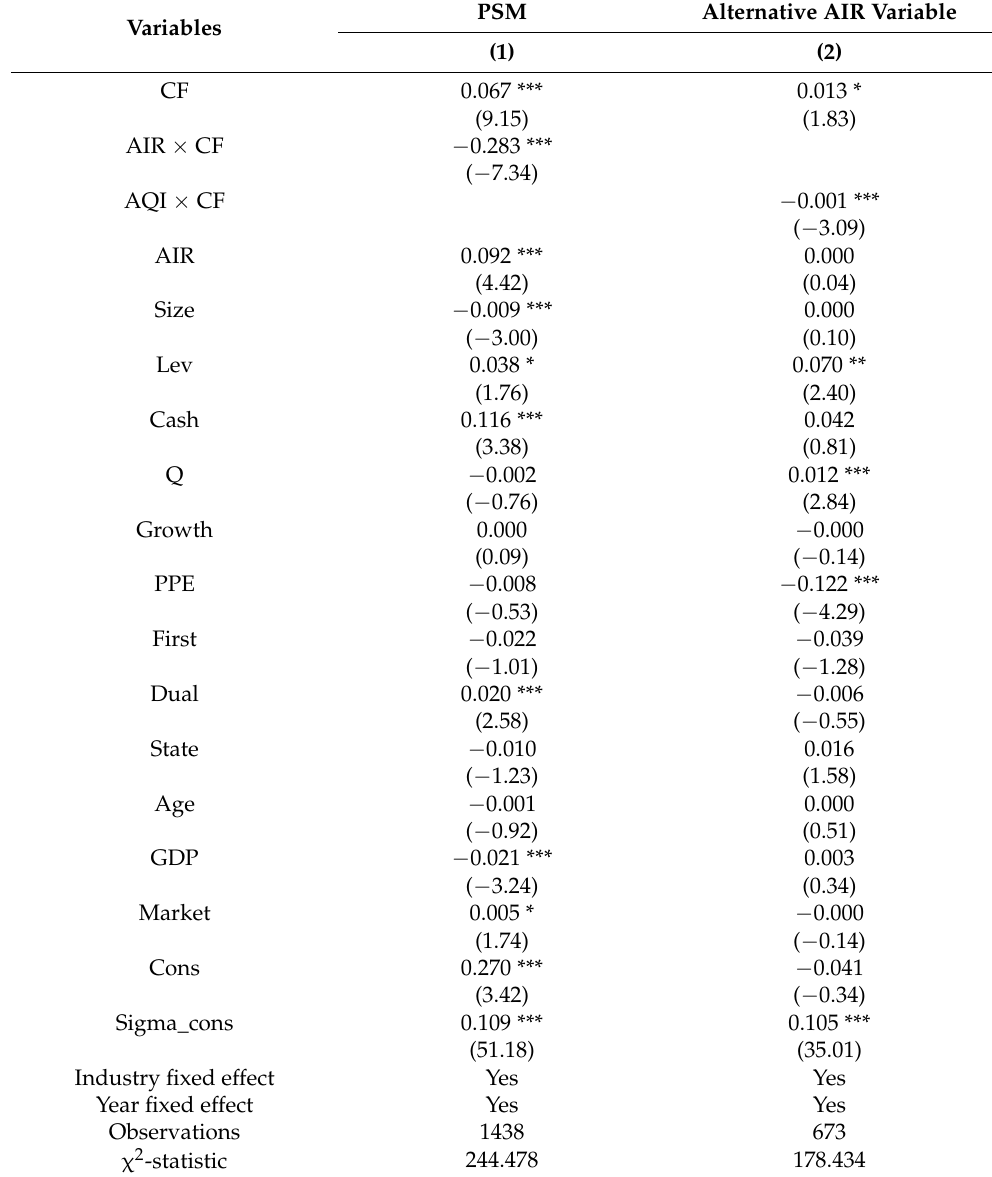
Table 11. Regressions with PSM and alternative AIR